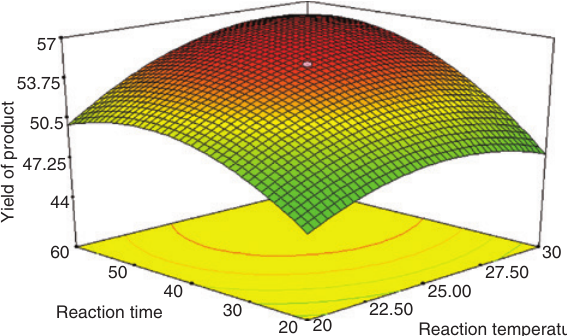
Figure 5: Response surface for effect of reaction temperature and reaction time on yield.